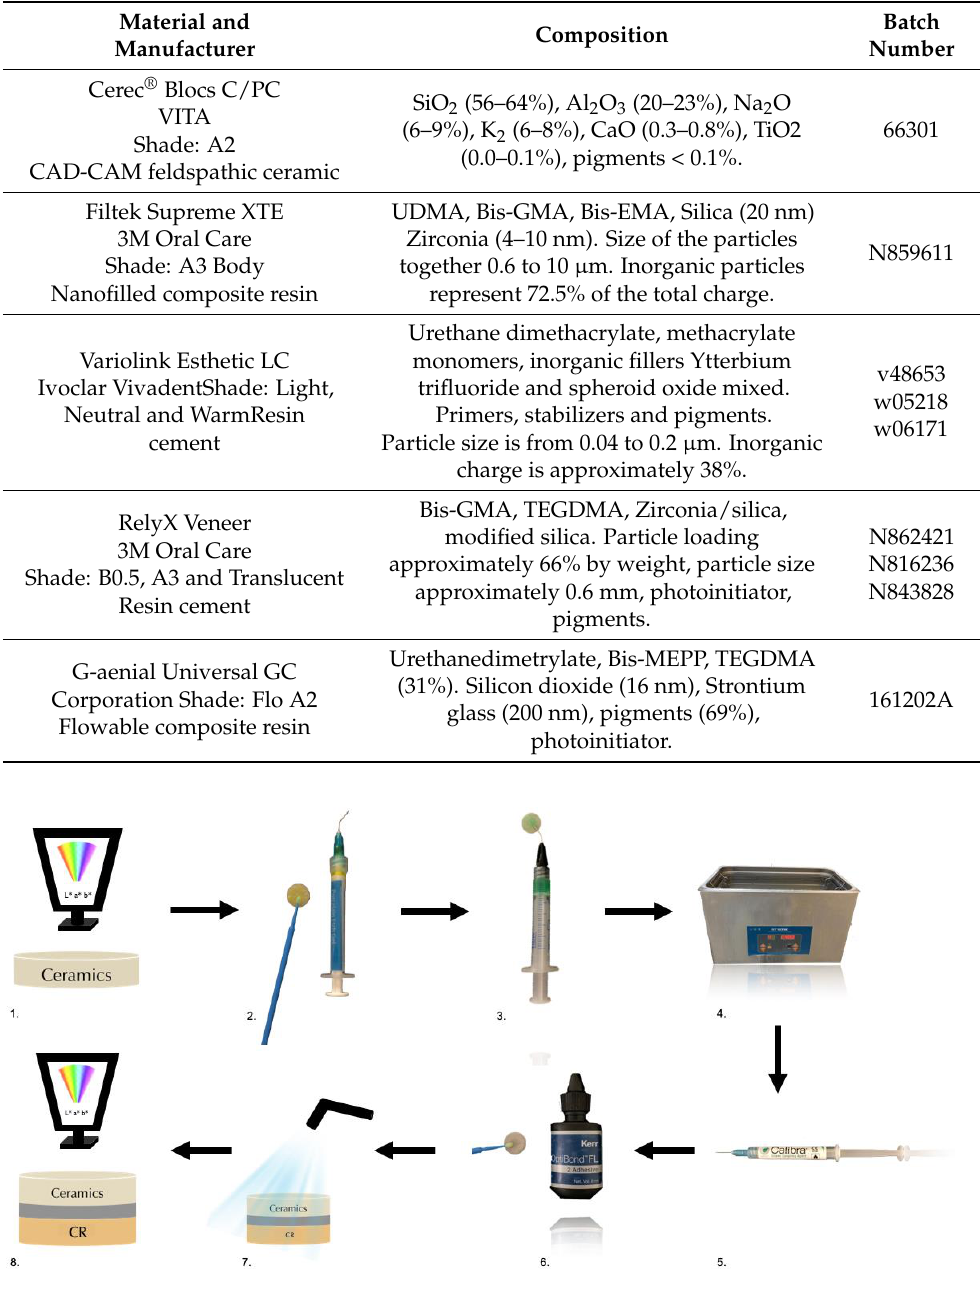
ple for each ceramic sample, before and after its cementation on a gray background [41,42]. Color difference (  E) was determined by L*, a* and b* values obtained by a spectro-